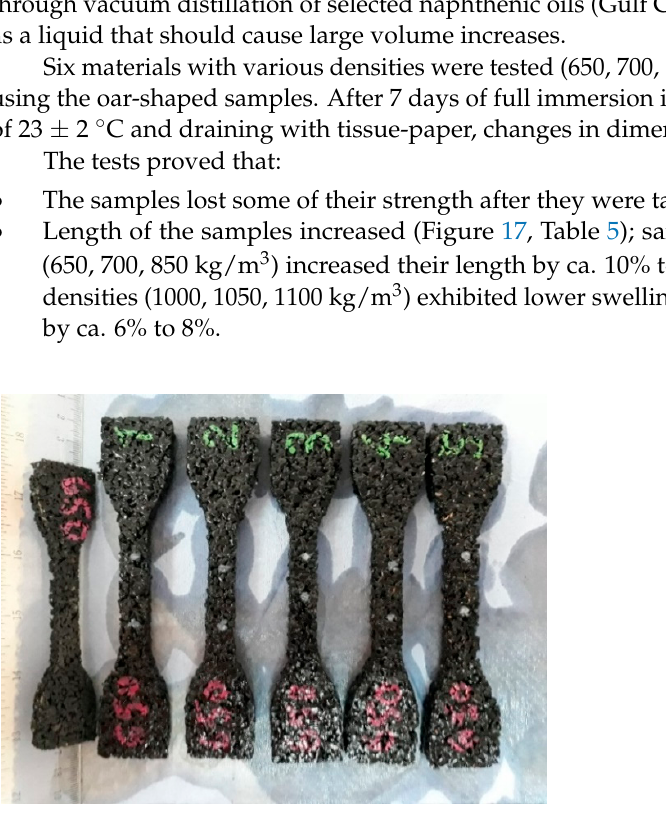
Figure 17. Change of length for sample SBR 650 after 7 days in oil.